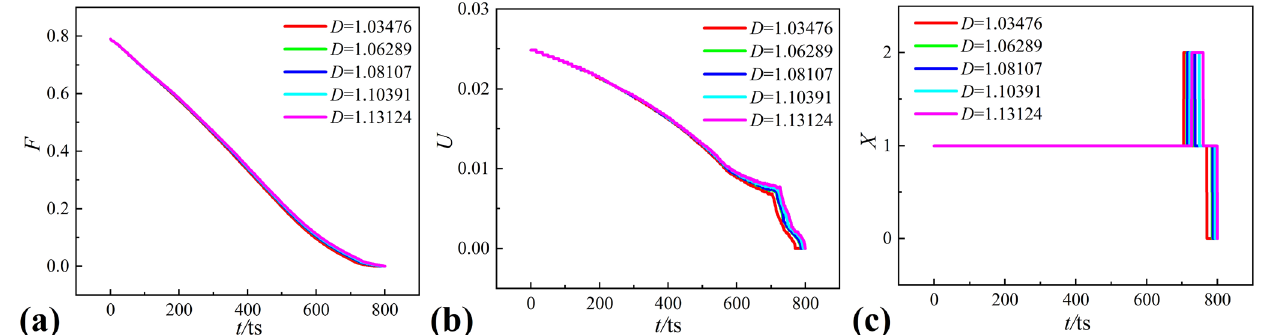
Figure 10. Morphological analysis of the collapsing bubble under different fractal dimensions: ( a ) fractional area F , ( b ) boundary length U , and ( c ) Euler characteristic X .